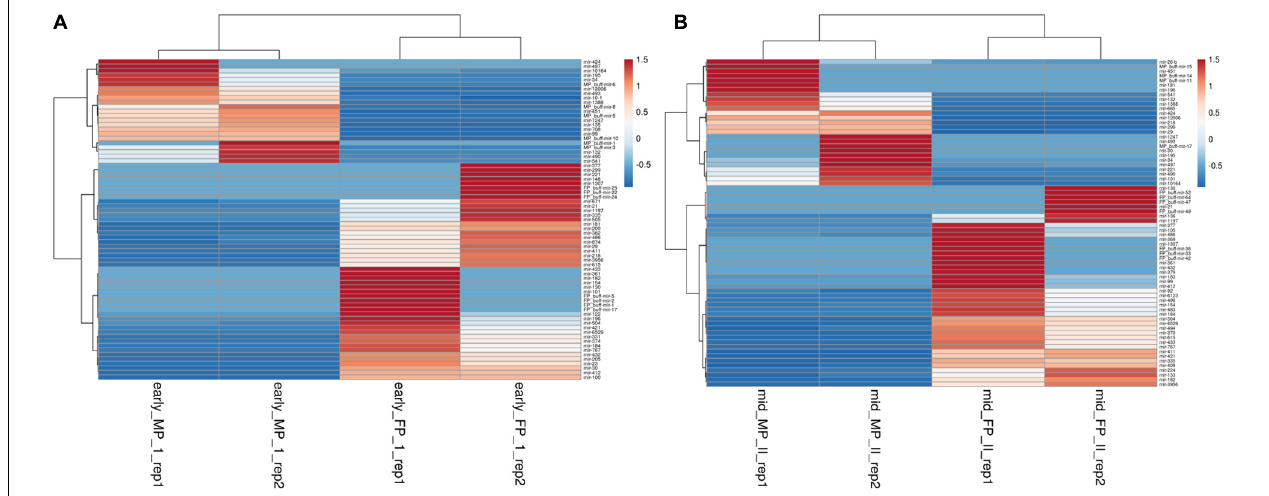
FIGURE 3 | Heat map for the differentially expressed miRNAs between fetal and maternal placentome during. (A) Early stage of pregnancy and (B) mid-stage of pregnancy, where red color depicts upregulated miRNA and blue color depicts miRNA that are downregulated. The scale bar from − 0.5 to 1.5 corresponds to the fold